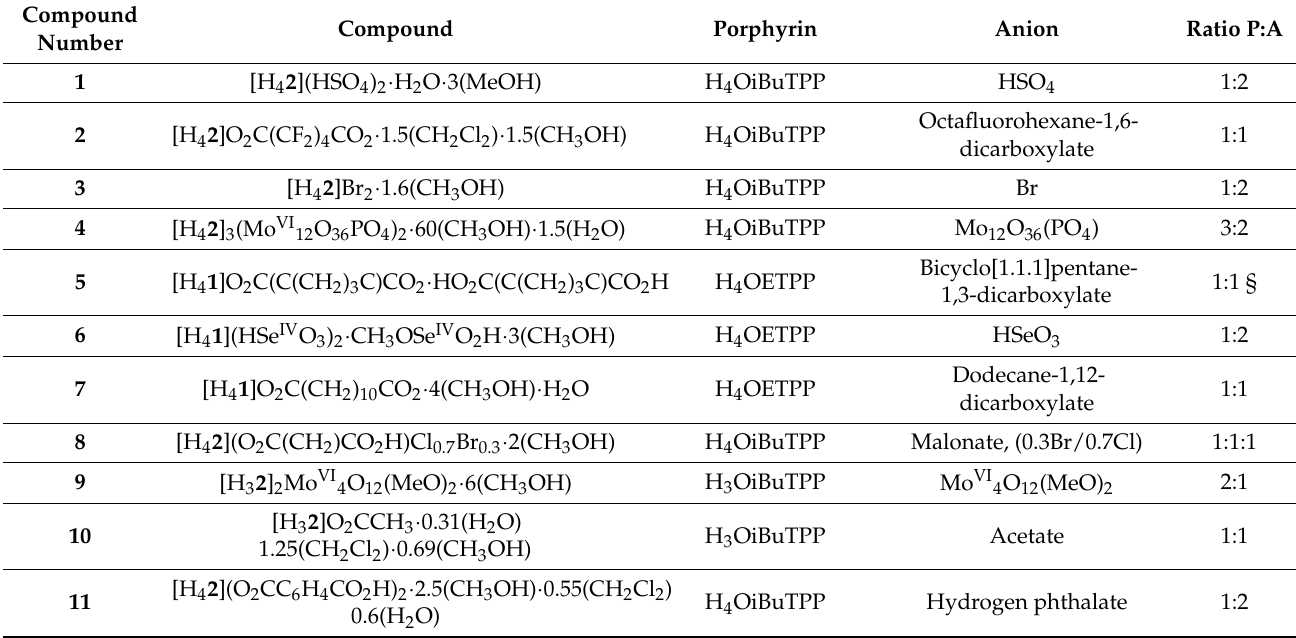
Table 1. The compounds discussed in this